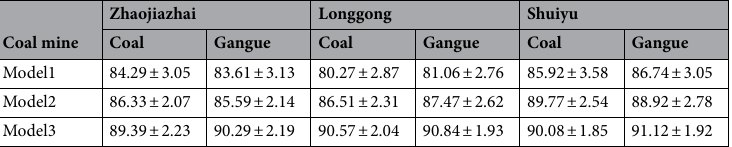
Table 5. Performance (average value ± standard deviation) comparison between three coal